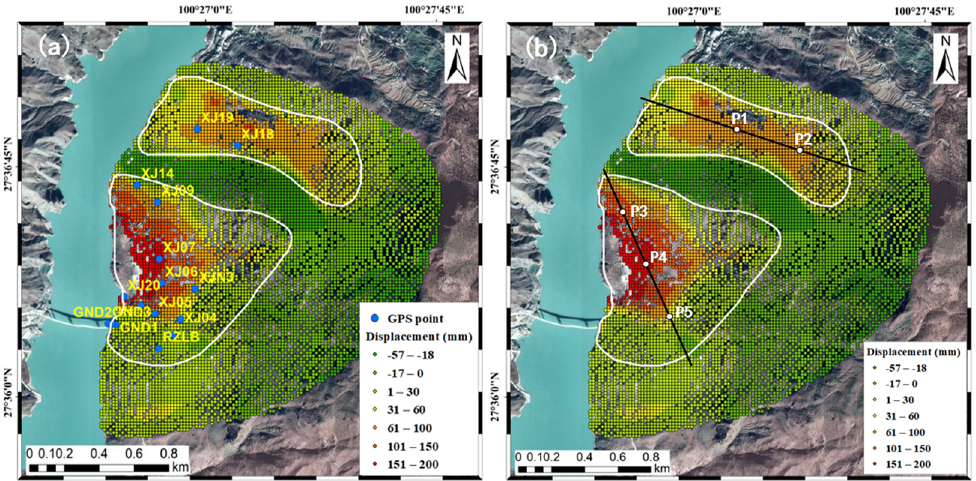
Figure 15. ( a ) Distribution of GPS monitoring points on the new landslide, ( b ) deformation rate of the new landslide and characteristic points. P1-P5 are selected InSAR feature points.